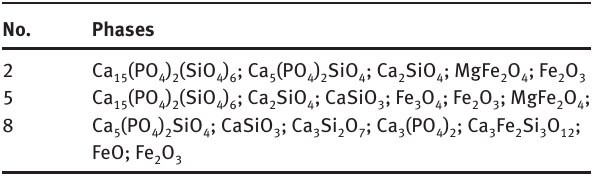
Table 4: Phases of sample No. 2, No. 5 and No.